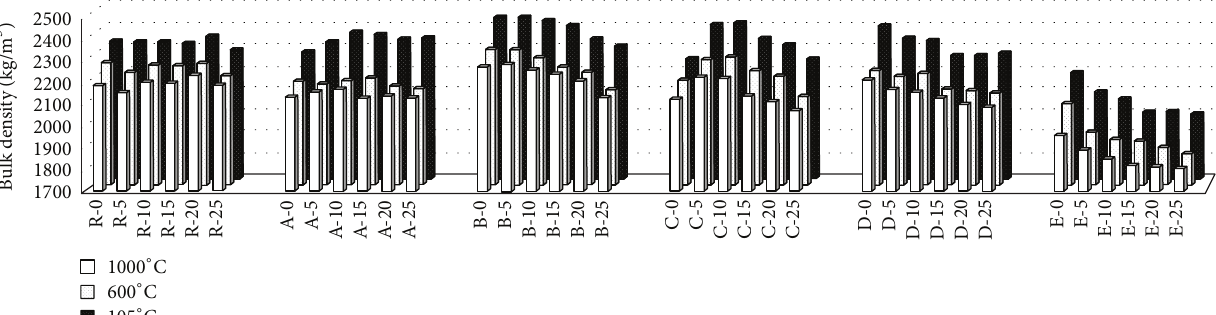
Figure 4: Impact of different composition and temperature loading on bulk density.